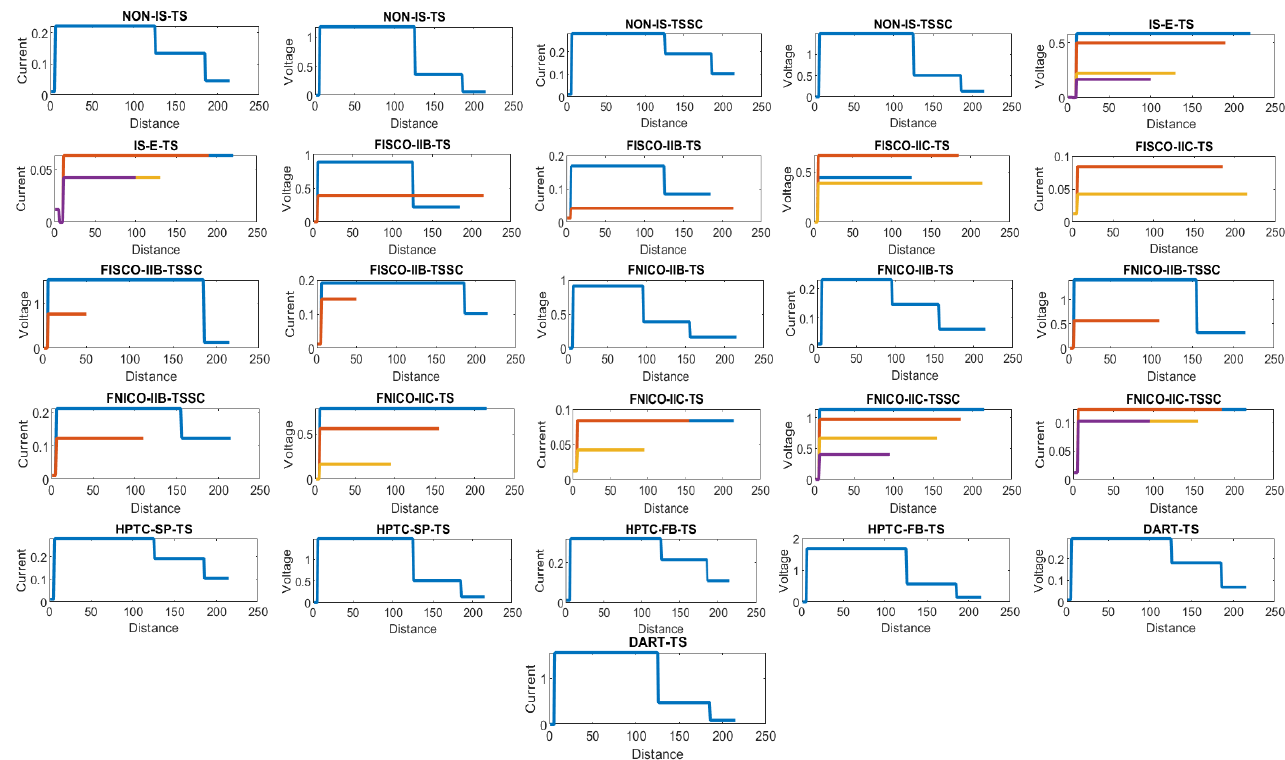
Figure 11. Current and voltage drop on the cables included in sub-models dedicated to top side tanks. Blue, brown, yellow and violet colors refer to segments from 1 to 4,